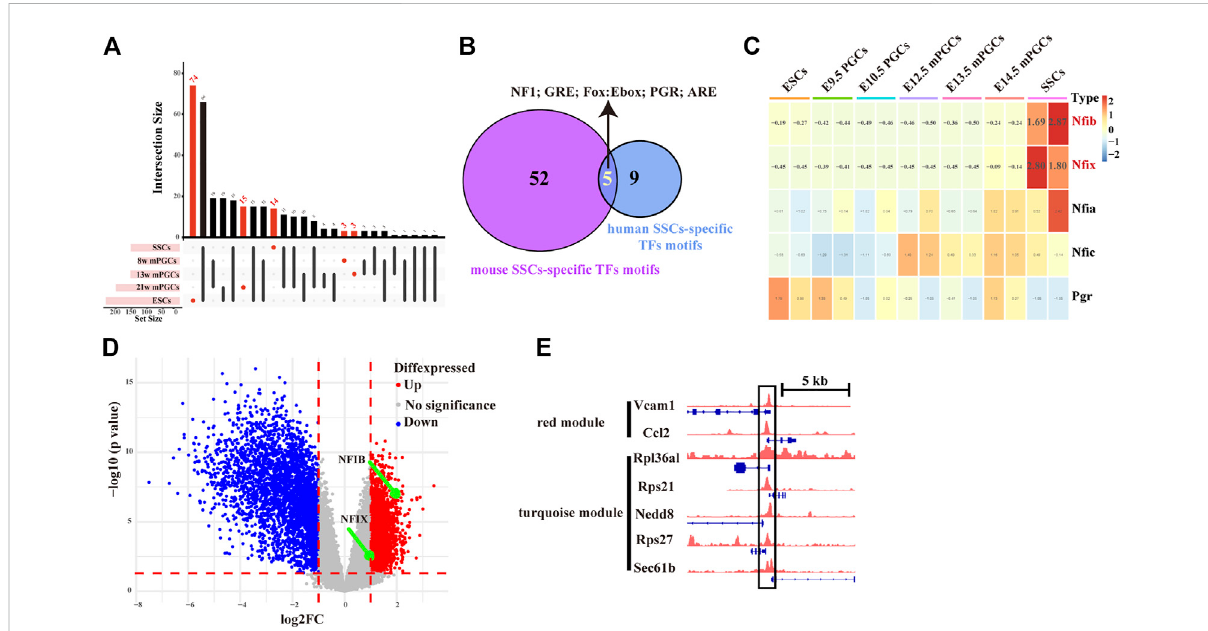
FIGURE 7 Screening ofkeySSC-speci fi cTFsandtheirtargetinghubSSC-speci fi cgenes. (A) UpSet diagramshowingthenumberofcell-speci fi cTFmotifs inhumanESCs,PGCs,andSSCs. (B) VenndiagramshowingoverlappingSSC-speci fi cTFsbetweenhumansandmice. (C) Heatmapshowingchanges inthegene expressionofoverlapping SSC-speci fi cTFs.The red colour intheheatmap indicates highexpression, andthe green colour indicateslow expression. (D) Volcano plot of differentially expressed genes between testis samples with impaired spermatogenesis and testis samples with normal spermatogenesis. (E) IGV screenshots of ChIP-seq data for NFIB at the hub SSC-speci fi c genes of the turquoise module ( Rpl36al , Rps27 , Rps21 , Nedd8 , and Sec61b ) and the red module ( Vcam1 and Ccl2